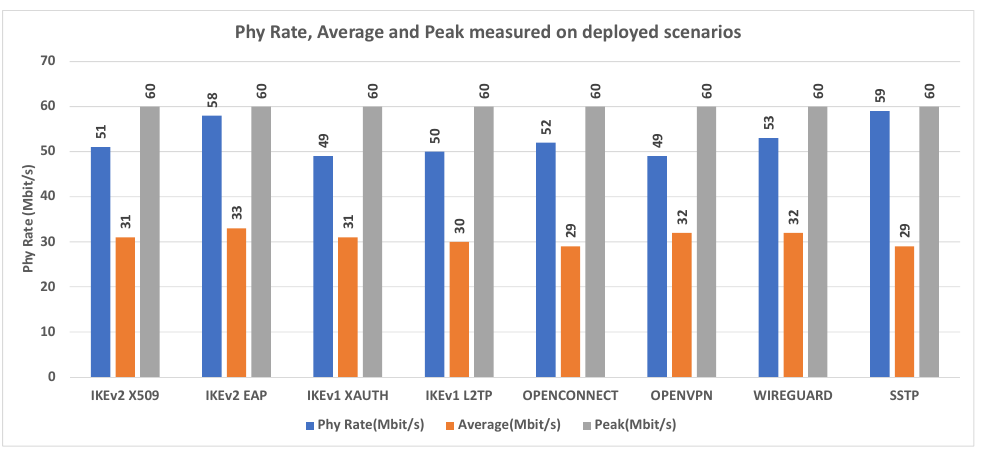
Figure 22. RTT of the OpenWRT VPN using different encryption algorithms. In Figure 23 the PHY RATE data collected during the VPN connection tests with wireless devices are shown.